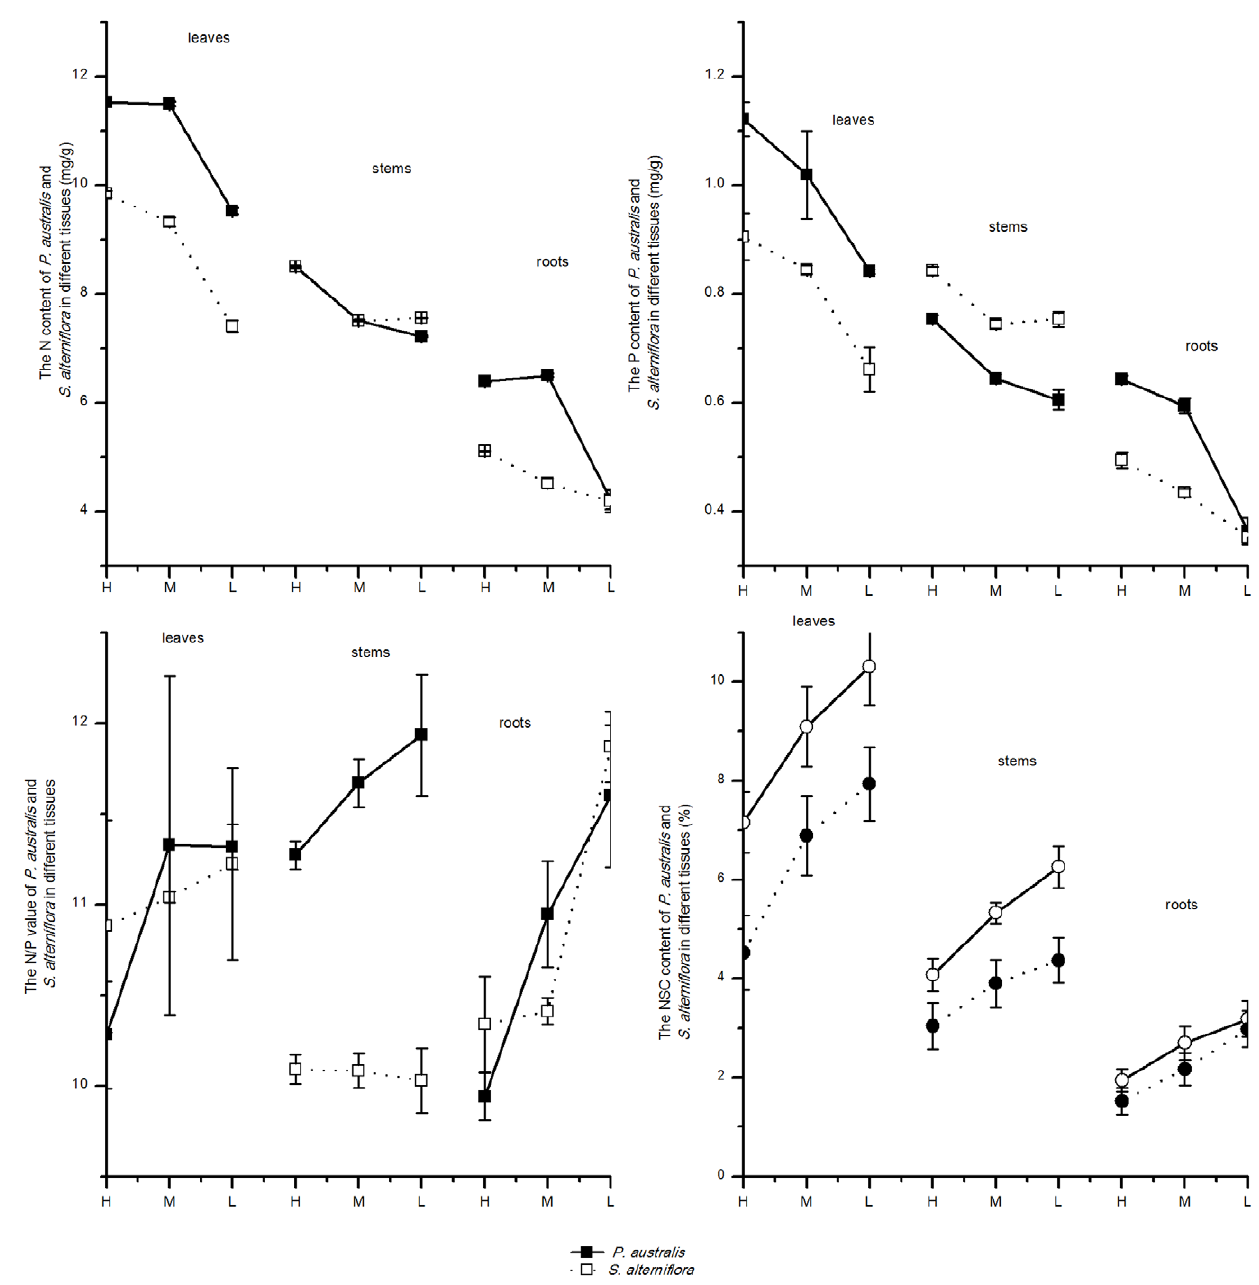
Figure 7. The physiological characteristics of P.australis and S.alterniflora along different tidal gradient. Physiological characteristics measured included non-structural carbohydrates (NSC), nitrogen (N) and phosphorus (P) contents, and N:P in different organs (leaves, stem, and roots) of the two species.